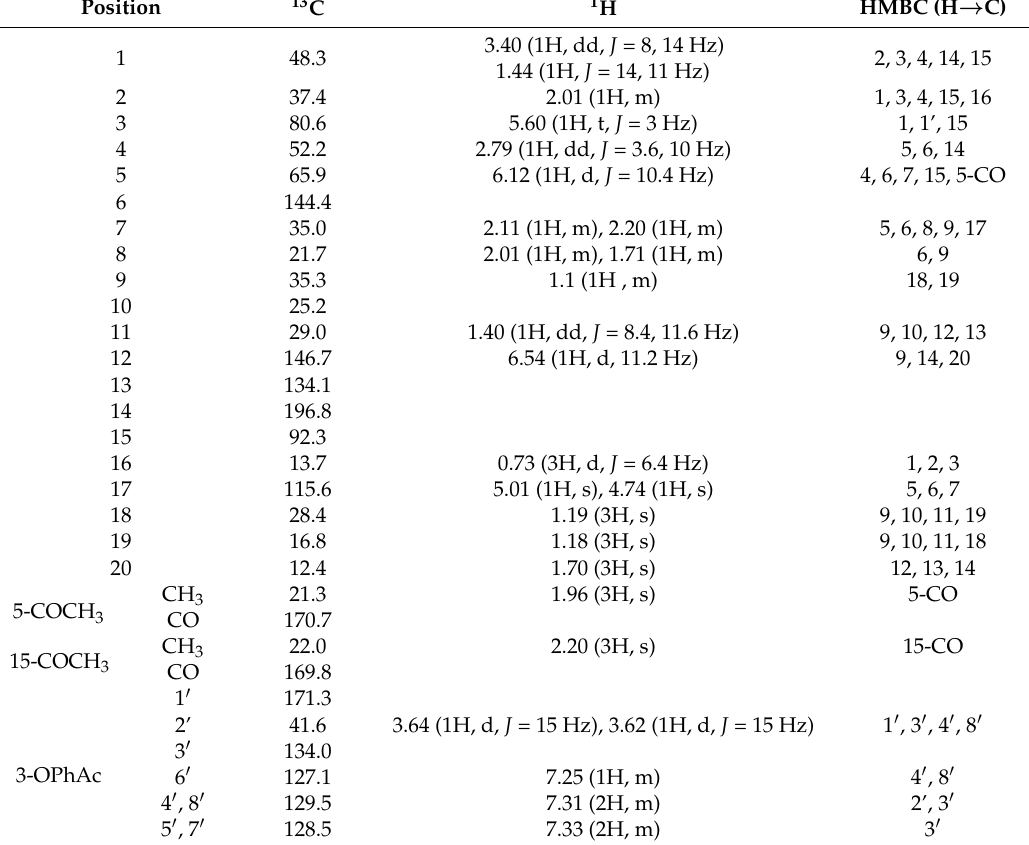
Table 1. 1 H- and 13 C-NMR data of DEFL1 ( δ , CDCl 3 , 500 and 125 MHz for 13 C and 1 H,